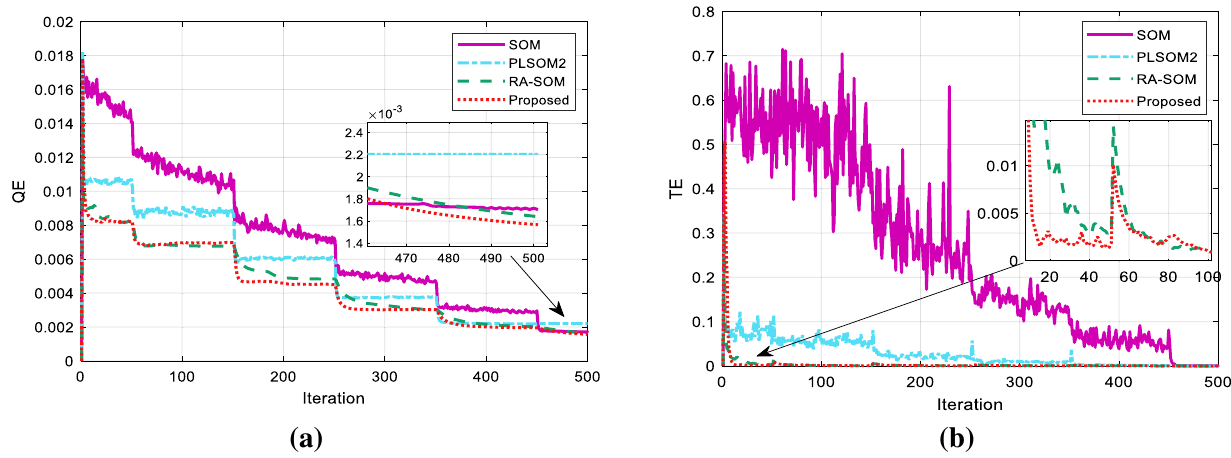
Fig. 4 Behavior of the conventional SOM, PLSOM2, RA-SOM and proposed VLR-SOM over 500 iterations a QE, and b TE Table 4 Comparison of CPU Iterations CPU time (s) time for conventional SOM, PLSOM2, and proposed Conventional SOM PLSOM2 RA-SOM Proposed method (VLRSOM) VLRSOM algorithms on the synthetic data 200 15.6406